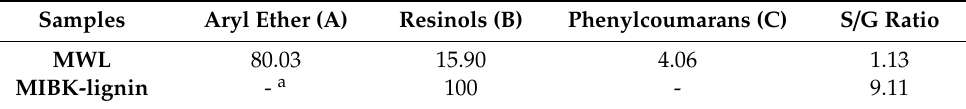
Table 3. Percentage of lignin interunit linkages and units in the samples.